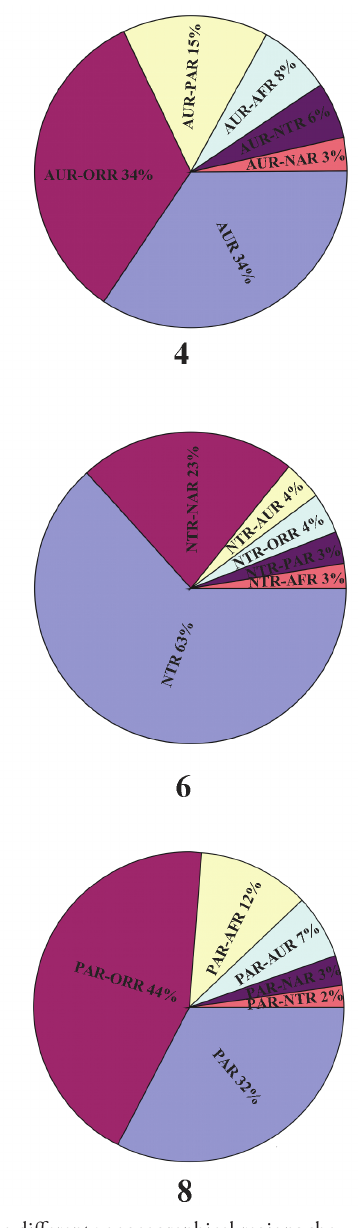
Figures 3–8. Distribution of genera of Galerucinae s. str. in the different zoogeographical regions show- ing generic endemism percentage and percentage of the genera shared with other regions. 3 Afrotropical Region (AFR) 4 Australian Region (AUR) 5 Nearctic Region (NAR) 6 Neotropical Region (NTR) 7 Ori- ental Region (ORR) 8 Palaearctic Region